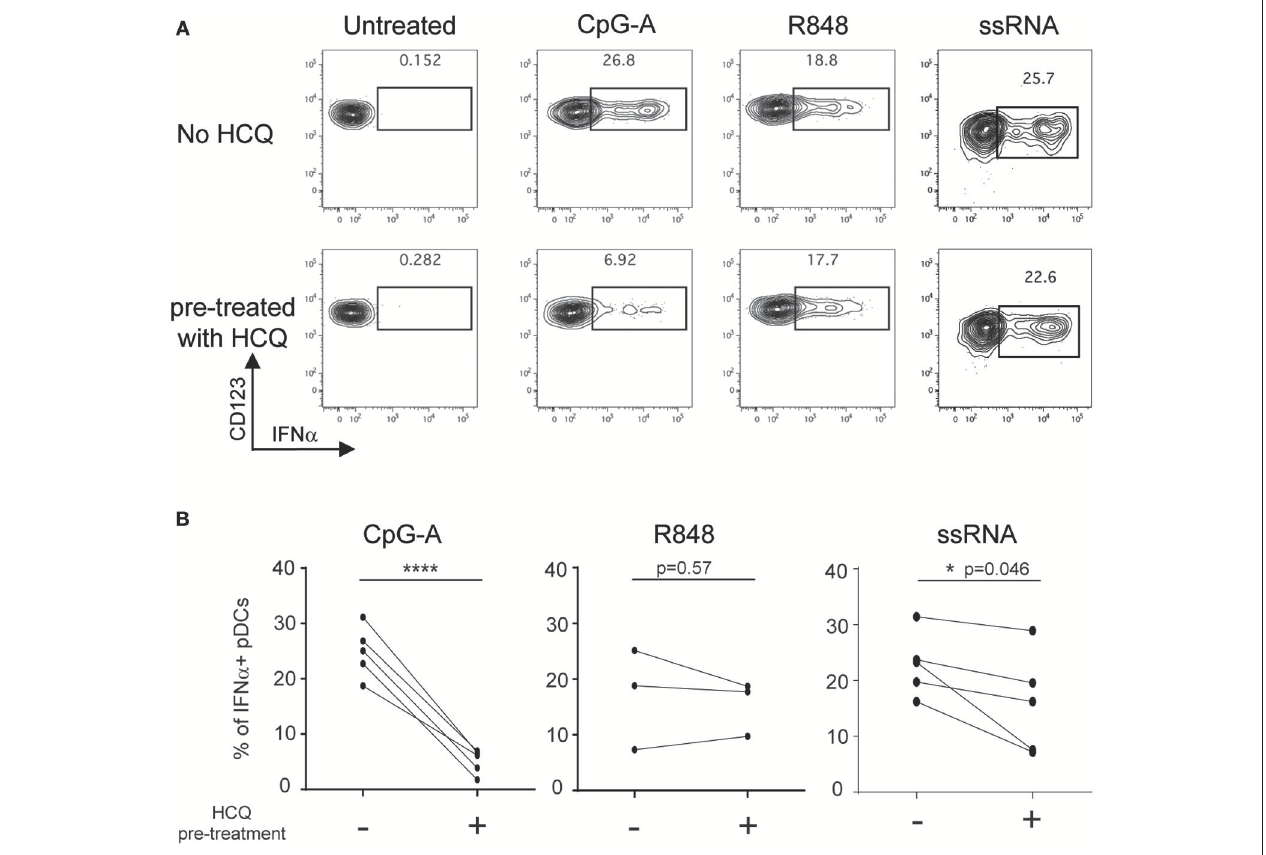
FIGURE 2 | HCQ-mediated inhibition of IFN α production from pDCs in response to CpG-A and ssRNA, but not to R848, can be detected after isolation of PBMC from whole blood pre-treated with HCQ. Whole blood samples from healthy donors were treated with HCQ (1000ng/ml) or not for 1h prior to PBMC isolation and then stimulated with CpG-A (10 µ M), R848 (1 µ M) or ssRNA (4 µ g/ml) for 6h. IFN α was analyzed by intracellular cytokine staining. (A) Representative dot plots of IFN α + cells within a BDCA4+ and CD123+ gate. (B) Percentages of IFN α -producing pDCs detected as shown in A ) after CpG-A stimulation ( n = 5 donors), R848 stimulation ( n = 3 donors), or ssRNA ( n = 5 donors) from PBMC isolated from whole blood pre-treated with HCQ or not. Statistical significance was assessed using two-tailed paired Student’s t-test (* p < 0.05, **** p <